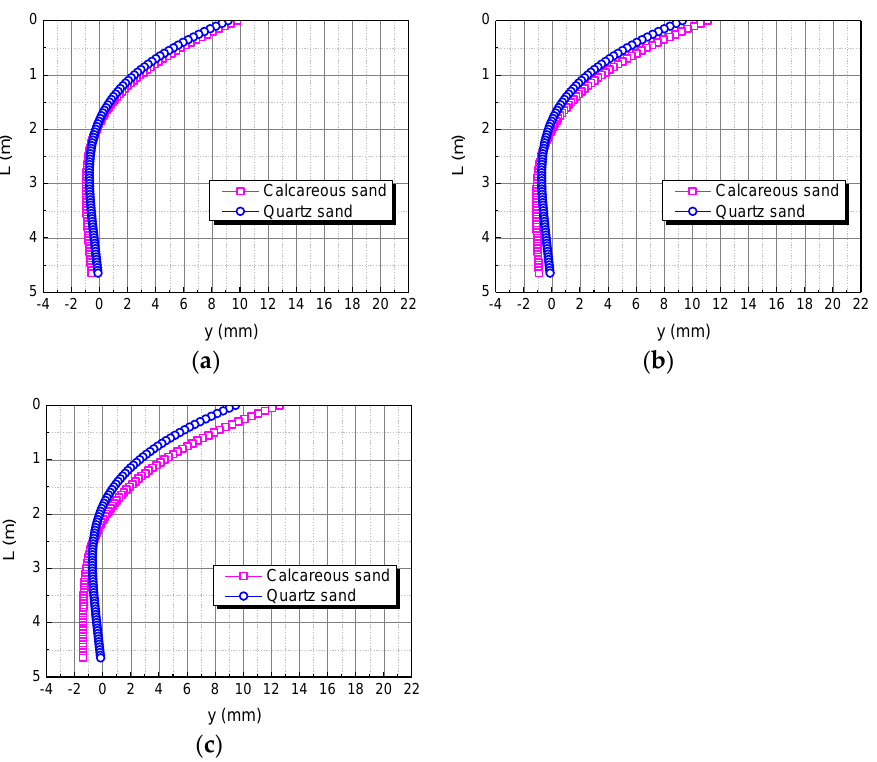
Figure 17. Effect of void ratio on horizontal displacement of pile. ( a ) e; ( b ) 1.1e; ( c ) 1.2e.